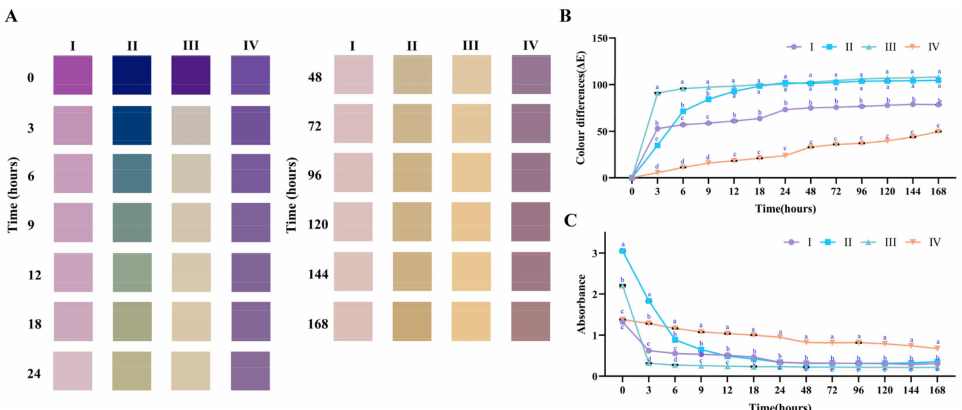
Figure 3. The stability evaluation of anthocyanin complex at 40 ◦ C storage within 168 h. ( A ). The colour swatch; ( B ) the colour changes; ( C ) the absorbance changes; I: ACNs (0.4 mg/mL); II: ACNs (0.4 mg/mL) − PX (12.0 mg/mL); III: ACNs (0.4 mg/mL) − ECT (120.0 mg/mL); IV: ACNs (0.4 mg/mL) − DG (120.0 mg/mL). Groups with different letters indicate significant differences, p < 0.05; the same letters indicate non − significant differences, p >